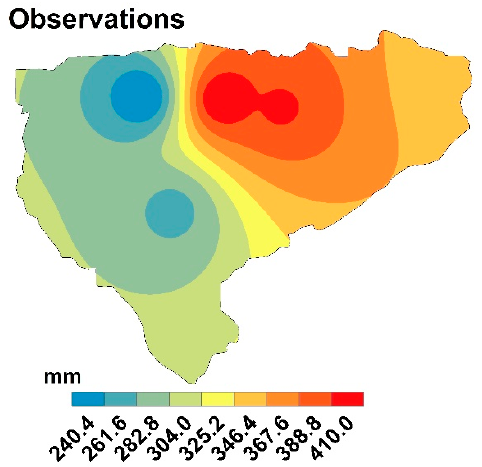
Figure 6. Rainfall map of the study area based on ground station data showing the average annual rates during the period 1998–2007.